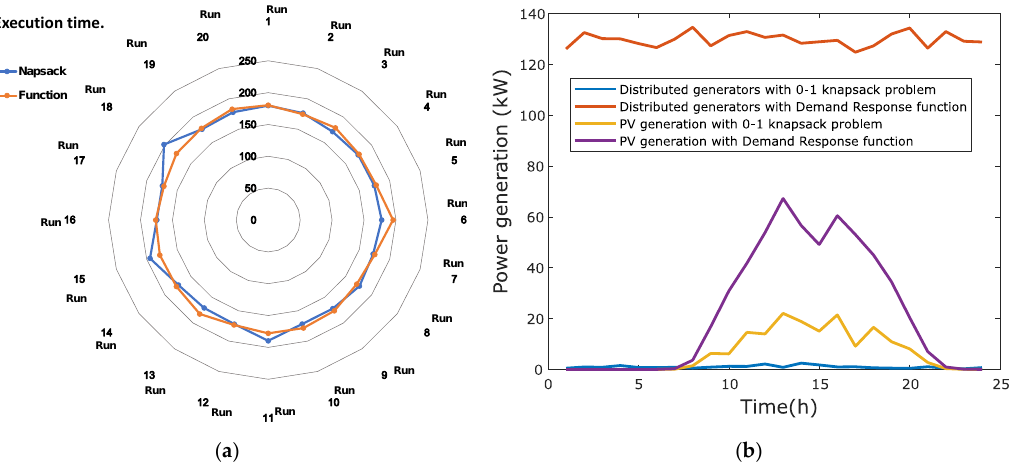
Figure 12. Results with the 0-1 KP and the DRF. ( a ) Execution time for 20 runs; ( b ) power exchanged by the electric vehicles (EVs) and the energy storage systems (ESSs).